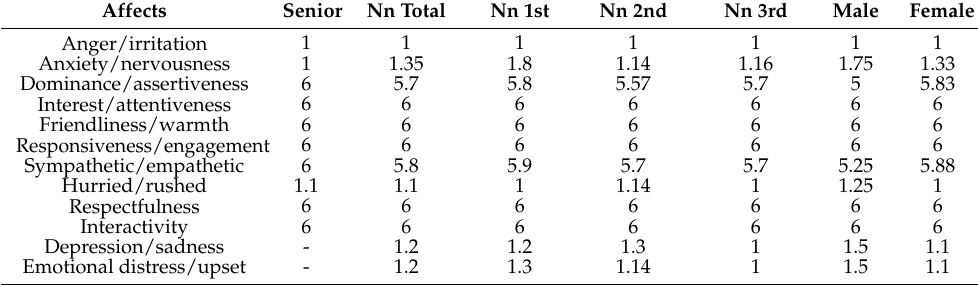
Table 6. Global affect